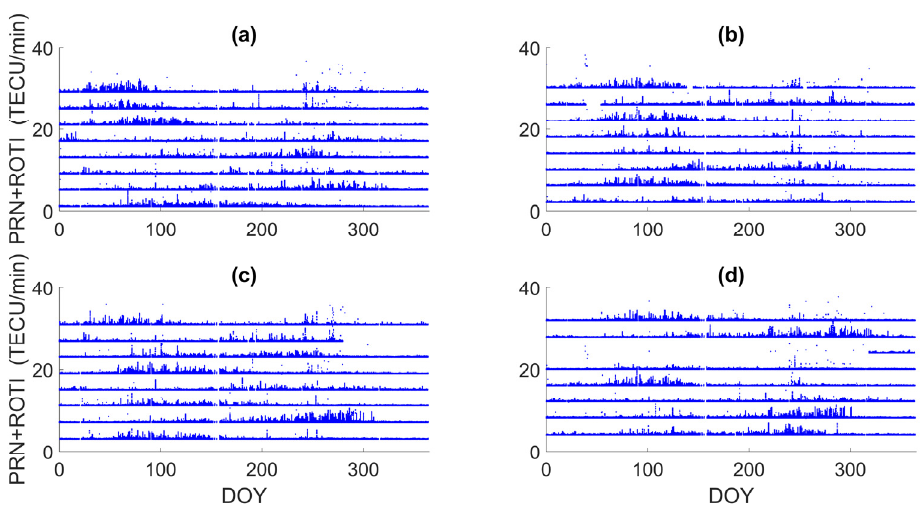
Figure 7. The time series of ROTI by day of year (DOY) for all of the observed GPS satellites at the WUHN site during 2012. The PRN numbers of each subfigure are as follows: ( a ) 1, 5, 9, 13, 17, 21, 25, 29;( b ) 2, 6, 10, 14, 18, 22, 26, 30;( c ) 3, 7, 11, 15, 19, 23, 27, 31; ( d ) 4, 8, 12, 16, 20, 28, 32.